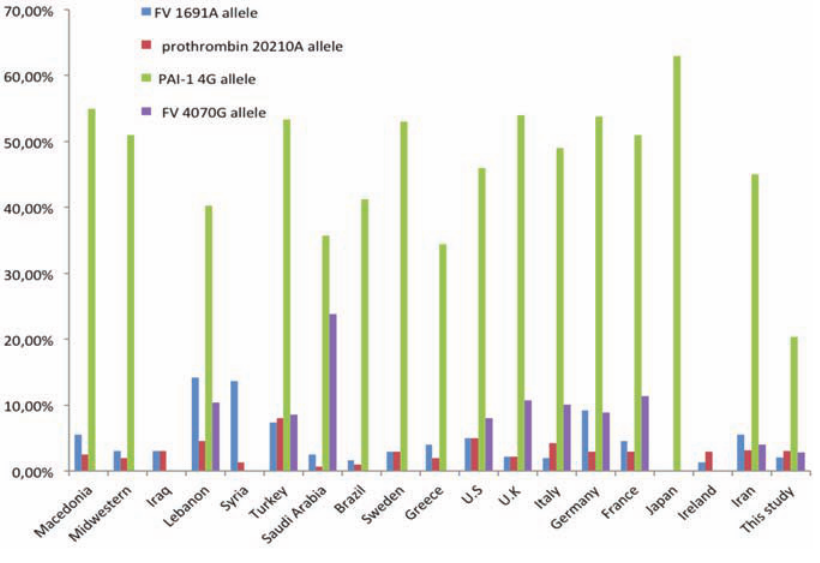
Figure 1. Comparison of the prevalence of FV (1691A and 4070G), prothrombin 20210A and PAI-1 4G allele polymorphisms among different